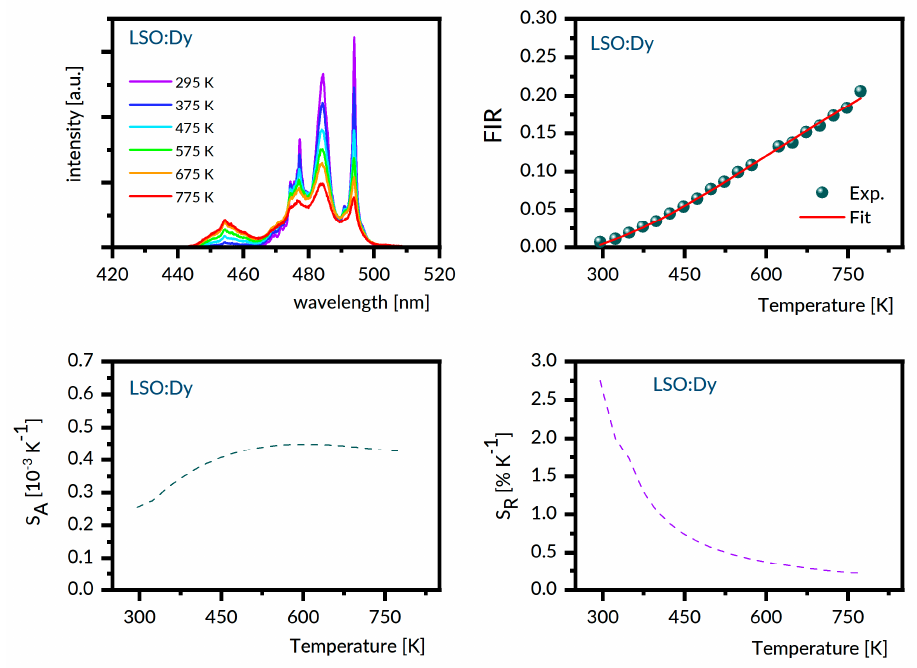
Figure 10. LSO:Dy emission spectra recorded at several different temperatures ( upper left) , the plot of FIR versus temperature ( upper right ), the temperature dependence of S A ( lower left ), and the temperature dependence of S R ( lower right ). Each figure contains graphs showing spectra at several different temperatures (upper left), the plot of FIR versus temperature (upper right), the temperature dependence of S A (lower left), and the temperature dependence of S R (lower right). Our S R values